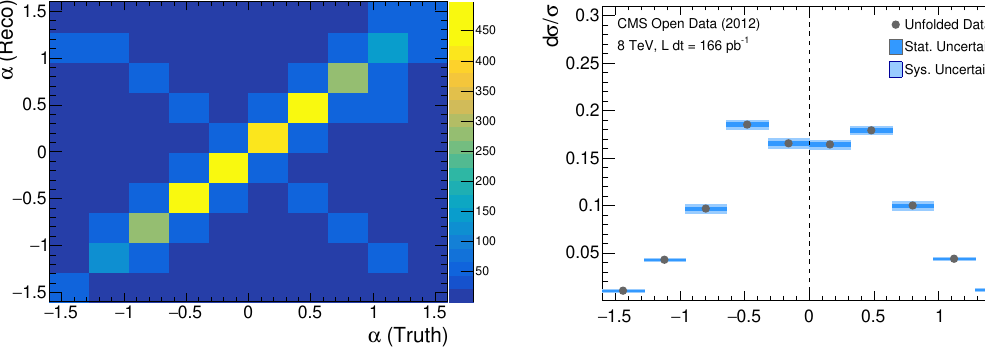
Figure 7 . Unfolding Matrix used in the iter- ative unfolding procedure, where the truth (cid:11) values are shown on the x-axis and the corre- sponding reconstructed values on the y-axis.